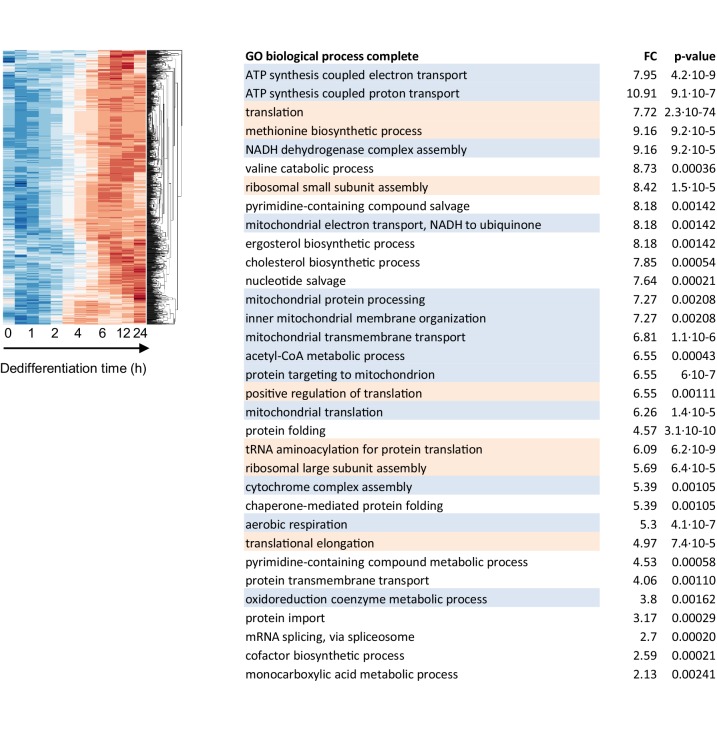
Functional enrichment analysis of genes induced during dedifferentiation.Left panels show enlarged segment of Figure 2—figure supplement 5 showing the ‘on’ cluster (990 genes). The accompanying GO table is shown on the right, with the genes enriched for translation (orange) and mitochondrial respiration (blue).